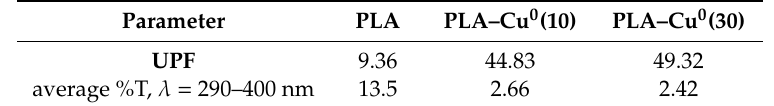
Table 5. Ultraviolet protection factor (UPF) values of non-woven fabric samples modified by magnetron sputtering.